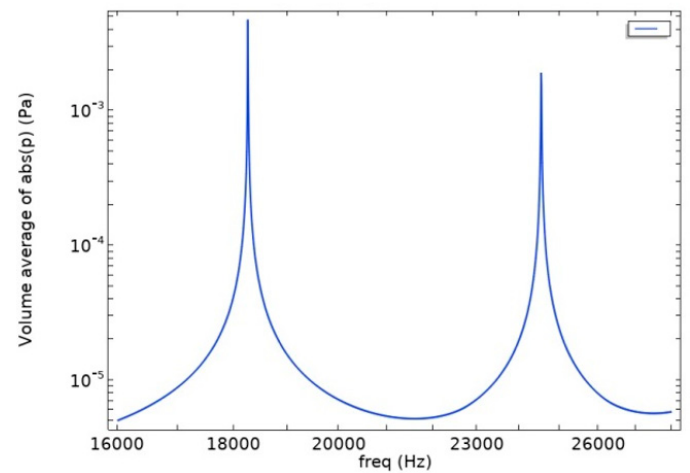
Figure 3. Frequency–response curve of the SPAC.